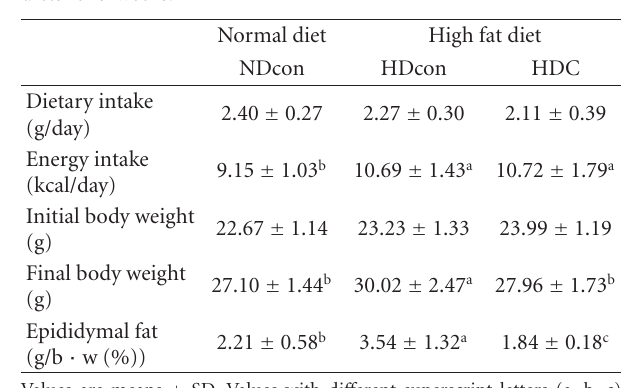
Table 3: Body weight and food intake in mice fed experimental diets for 9 weeks.